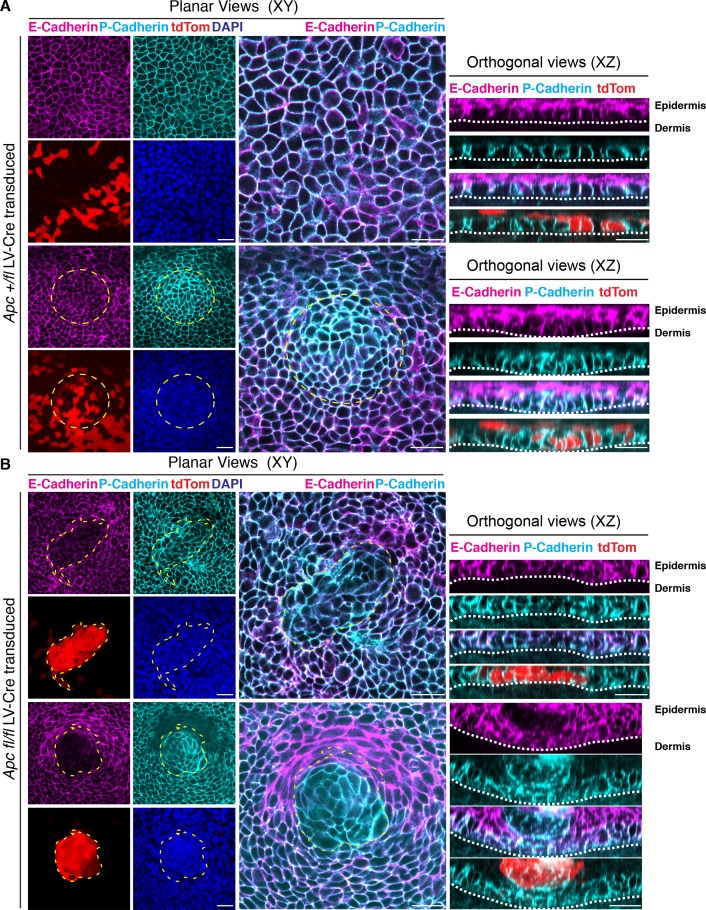
Apc-null cell clusters lose adherens junction transmembrane protein E-Cadherin.Representative E14.5 whole-mount immunofluorescence images and respective orthogonal views from (A) Apc-het and (B) Apc-null transduced tdTomato+ embryonic skins showing endogenous E-Cadherin and P-Cadherin immunofluorescence. Note loss of E-Cadherin in Apc-null clusters when compared to the surrounding wild-type skin. Circular yellow dashed line outlines a heterozygous placode while remain dashed lines contour Apc-null cell clusters. White dotted lines demarcate epithelial-mesenchymal boundaries. The XY axis is planar to the epidermis; the XZ axis shows sagittal views perpendicular to the skin surface. Scale bars, 20 μm.